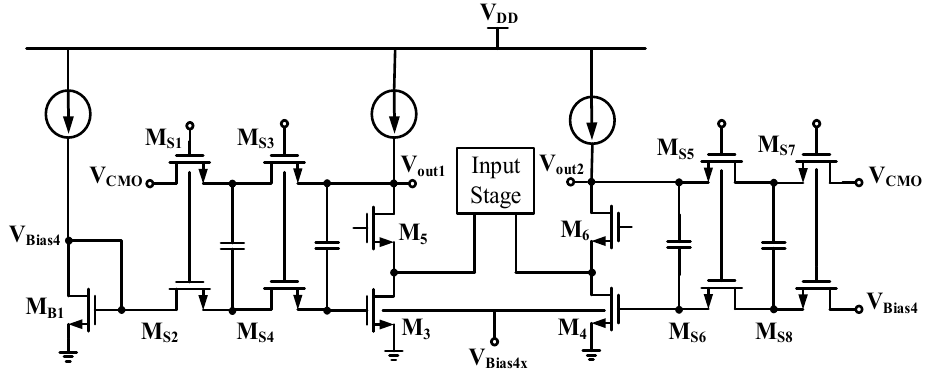
Figure 6. The switched-capacitor common mode feedback circuit.